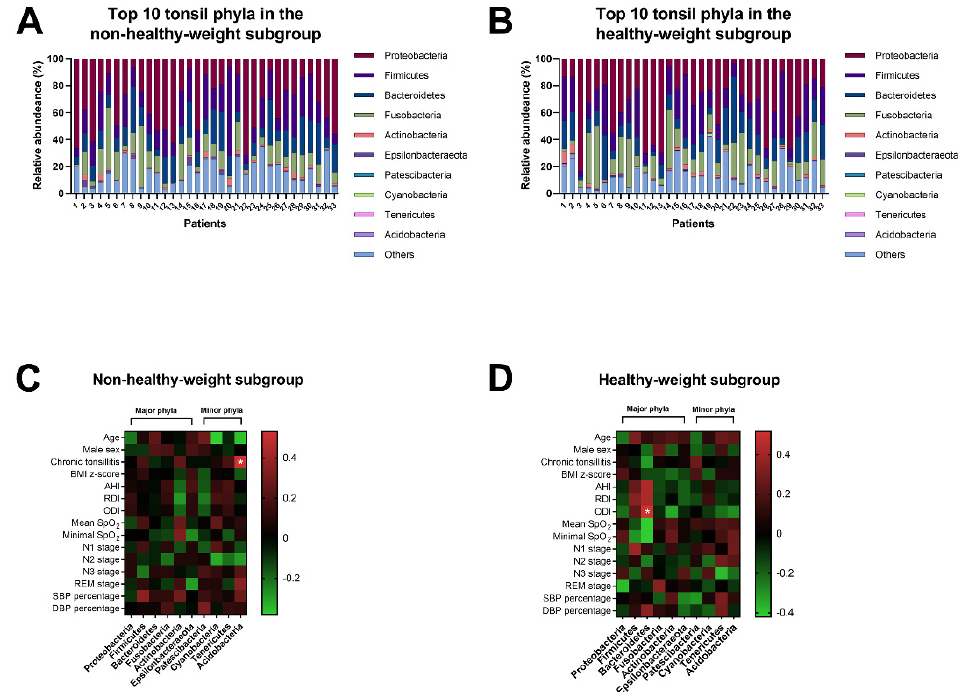
Figure 3. The top 10 tonsil phyla in both weight status subgroups. The relative abundances of the top 10 tonsil phyla in the non-healthy-weight subgroup ( A ) and the healthy-weight subgroup ( B ) ( p = 0.651; analysis of similarity test). Chronic tonsillitis was significantly associated with a relative abundance of Acidobacteria in the non-healthy-weight subgroup ( r = 0.53, q = 0.015) ( C ), whereas the oxygen desaturation index (ODI) was significantly associated with Bacteroidetes in the healthy-weight subgroup ( r = 0.52, q = 0.020) ( D ). Abbreviations: AHI, apnea–hypopnea index; BMI, body mass index; RDI, respiratory disturbance index; REM, rapid eye movement; SpO 2 , pulse oxygen saturation.